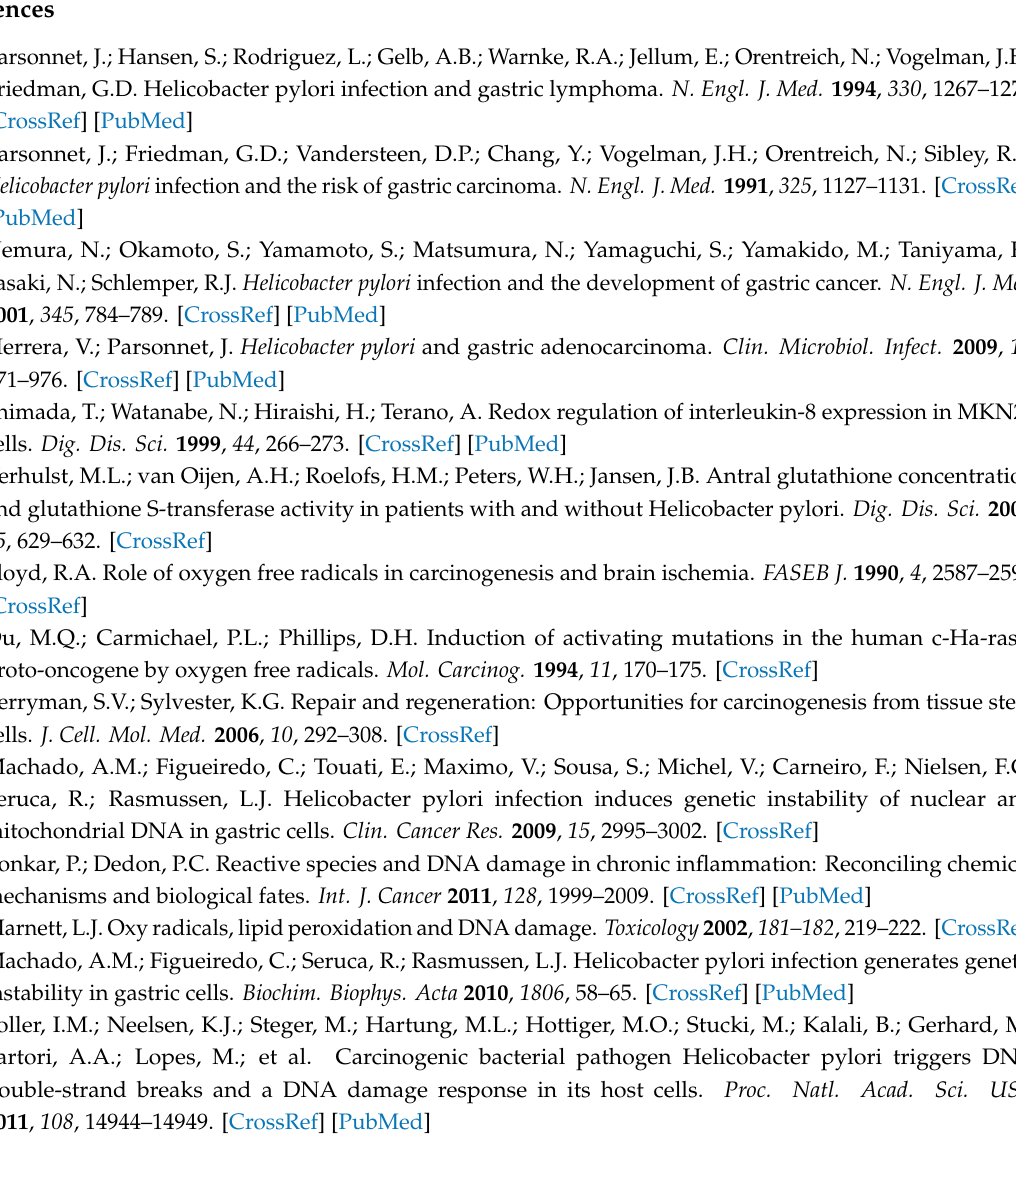
Figure S1: Apoptosis moderately increase in aberrant BER mice, Table S1: List of primers for gene expression, Table S2: List of primers for mutation